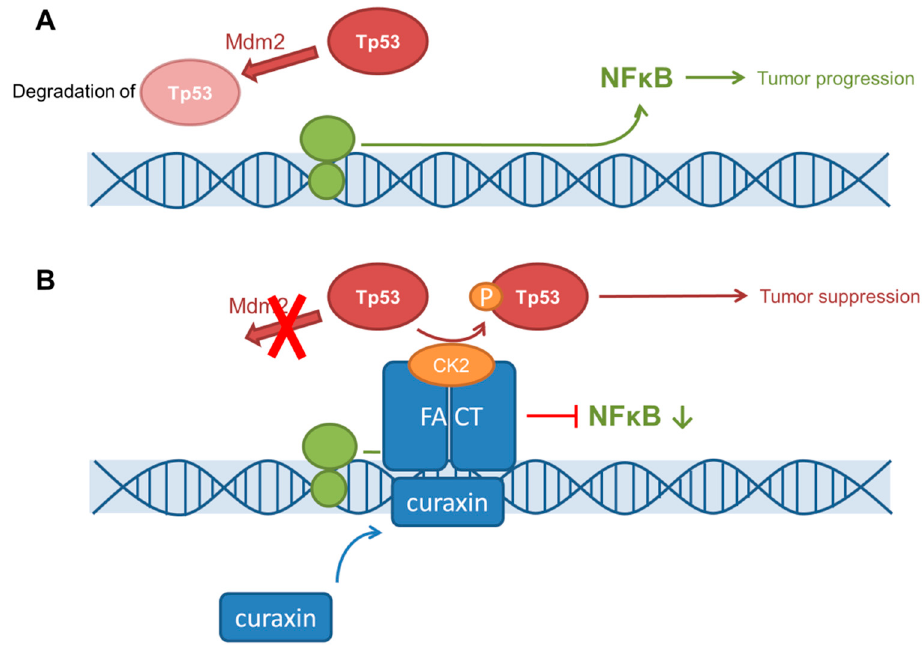
Figure 2. Curaxins’ mechanism of action [145]. ( A ) Without curaxin interaction, Tp53 is degraded by mouse double minute 2 homolog (Mdm2) and the NF κ B gene region is transcripted and translated. ( B ) By interaction with curaxin, FACT binds to the DNA double strand and inhibits the transcription of the NF κ B gene region. Additionally, casein kinase 2 (CK2) phosphorylates Tp53 and therefore, reduces its degradation.